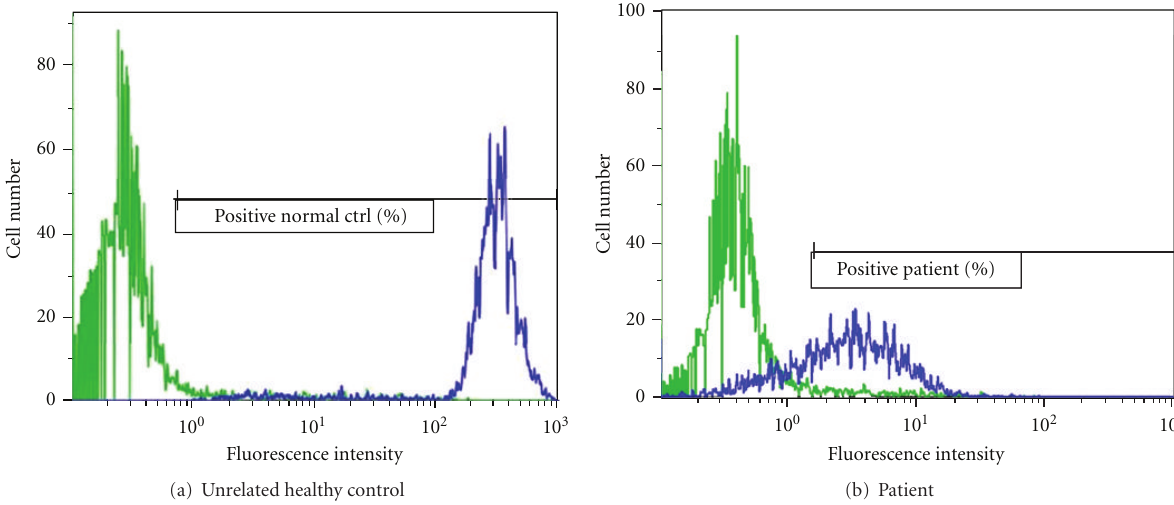
Figure 4: Dihydrorhodamine-123 (DHR) fluorescence assay in peripheral-blood neutrophils from the patient and an unrelated healthy control are displayed. In this assay, neutrophils are stimulated with phorbol myristate acetate (PMA) in the presence of DHR, and flow cytometry is used to measure the oxidative burst mediated by NADPH oxidase by quantifying the fluorescent product. After PMA stimulation, the histogram from the control (a) shows a unimodal shift of fluorescence far to the right, whereas the patient has a broad- based shift in fluorescence that is only partially shifted to the right compared with the healthy control